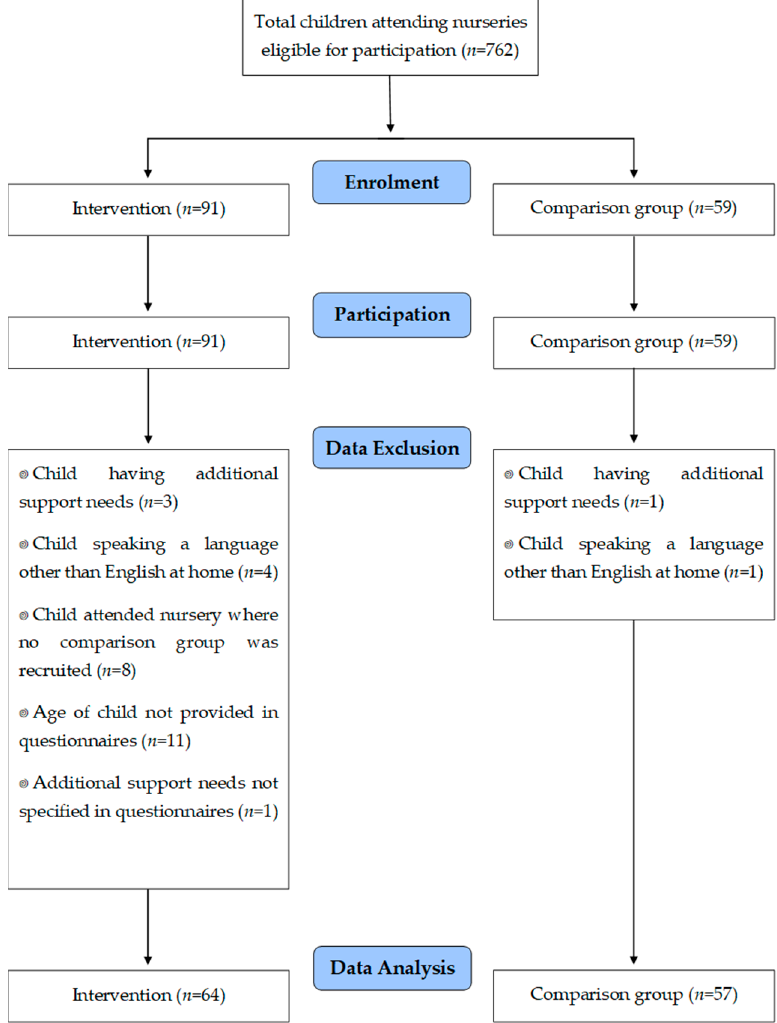
Figure 1. Participant recruitment and reasons for exclusion in data analysis. BCLC—Big Chef Little Chef. Figure1. Participantrecruitment andreasonsforexclusionindata analysis.